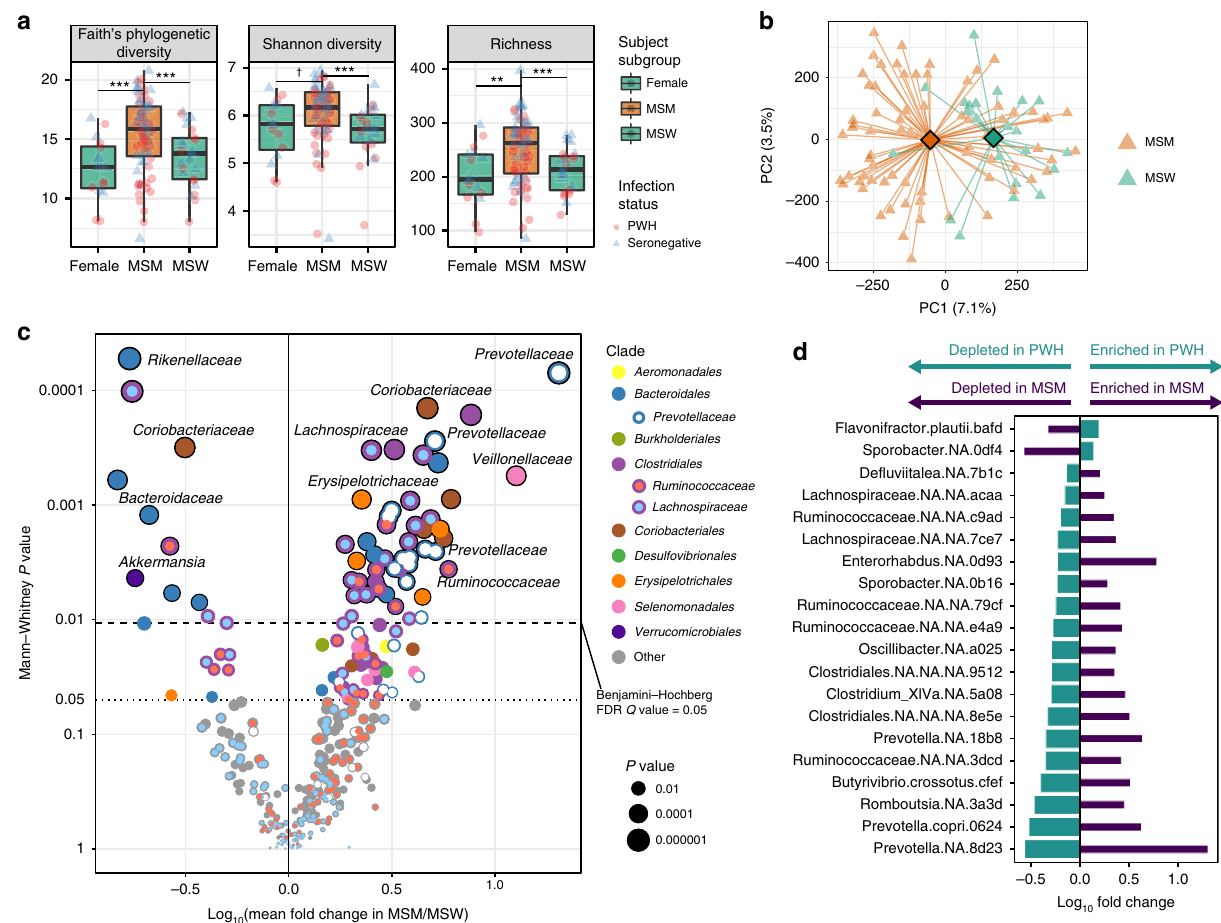
Prevotella.NA.8d23Prevotella.copri.0624Romboutsia.NA.3a3dButyrivibrio.crossotus.cfefRuminococcaceae.NA.NA.3dcdPrevotella.NA.18b8Clostridiales.NA.NA.NA.8e5eClostridium_XlVa.NA.5a08Clostridiales.NA.NA.NA.9512Oscillibacter.NA.a025Ruminococcaceae.NA.NA.e4a9Ruminococcaceae.NA.NA.79cfSporobacter.NA.0b16Enterorhabdus.NA.0d93Lachnospiraceae.NA.NA.7ce7Ruminococcaceae.NA.NA.c9adLachnospiraceae.NA.NA.acaaDefluviitalea.NA.7b1cSporobacter.NA.0df4Flavonifractor.plautii.bafd –0.5 0.0 Fig. 3 Sexual practice exerts major impact on gut microbiota composition. a Alpha diversity measures are shown for the three sex/sexual practice subgroups ( n = 16 female, n = 72 MSM, n = 25 MSW), with participants matched for birth country (Netherlands). Faith ’ s phylogenetic diversity P = 3×10 − 7 , Shannon Diversity P = 2.3×10 − 6 , Richness P = 3.2×10 − 7 by Kruskal – Wallis tests. † P <0.10, * P < 0.05, ** P <0.005, *** P <0.001 by Mann – Whitney U -tests. Boxes denote inter-quartile range, bar denotes median, and whiskers denote range. b Principal coordinates analysis (PCoA) plot based on Canberra beta diversity metric with centroids depicted as diamonds for MSM and MSW. Shown are participants matched for birth country (Netherlands) and infection status between the comparator groups of MSM and MSW ( n = 72 MSM [36 PWH and 36 seronegative] vs. n = 22 MSW [11 PWH and 11 seronegative]). Community differences were veri fi ed by PERMANOVA, P = 0.001. c Volcano plot depicting ASVs in differential abundance between MSM and MSW matched for infection status and birth country, using the unpaired non-parametric Mann – Whitney U test. ASVs are colored by either their order or family, and families of selected taxa are denoted by text. d A comparison of abundance trends among ASVs signi fi cantly differing in both the comparison of MSM vs. MSW and PWH vs. uninfected controls. ASVs were selected by P -value <0.05 in both comparisons (paired Wilcoxon for PWH vs. uninfected, unpaired Mann – Whitney for MSM vs. MSW). Directionality of ASV abundances are in opposition to each other and refute the expectation that having MSM